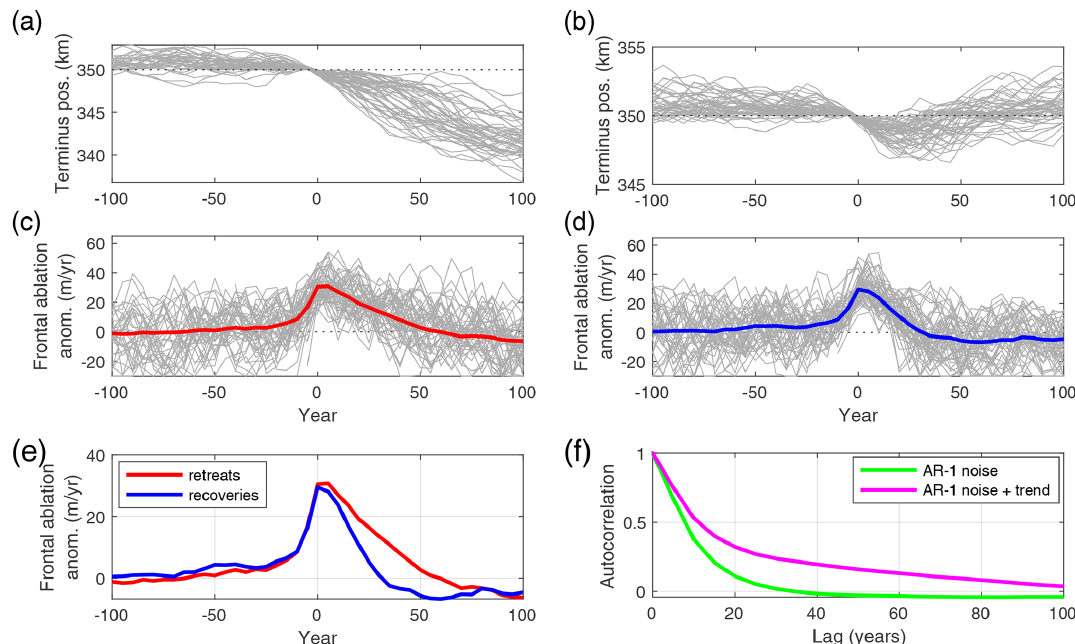
Figure 4. Unstable retreats are driven by persistent anomalies in climate forcing. (a) Unstable retreats from a 1000-member ensemble, synchronized to the time that retreat begins (only 50 members shown for clarity). (b) Synchronized members from the same ensemble that retreated > 1km from the bed peak but then recovered. (c) Synchronized frontal ablation anomalies for the retreat group in (a) , along with the group mean (red). (d) As for (c) but for the recovery group. (e) Group-mean frontal ablation anomalies plotted together. On average, the key difference between unstable retreats and recoveries is the persistence of the anomalies rather than the maximum at year 0. (f) Autocorrelation function of the AR-1 noise used to simulate frontal ablation anomalies (green) and autocorrelation of the same AR-1 noise plus a 150-year trend of similar magnitude to the variability. A trend will enhance persistence on the multidecadal time frames that set apart the retreat and recovery groups in (e)